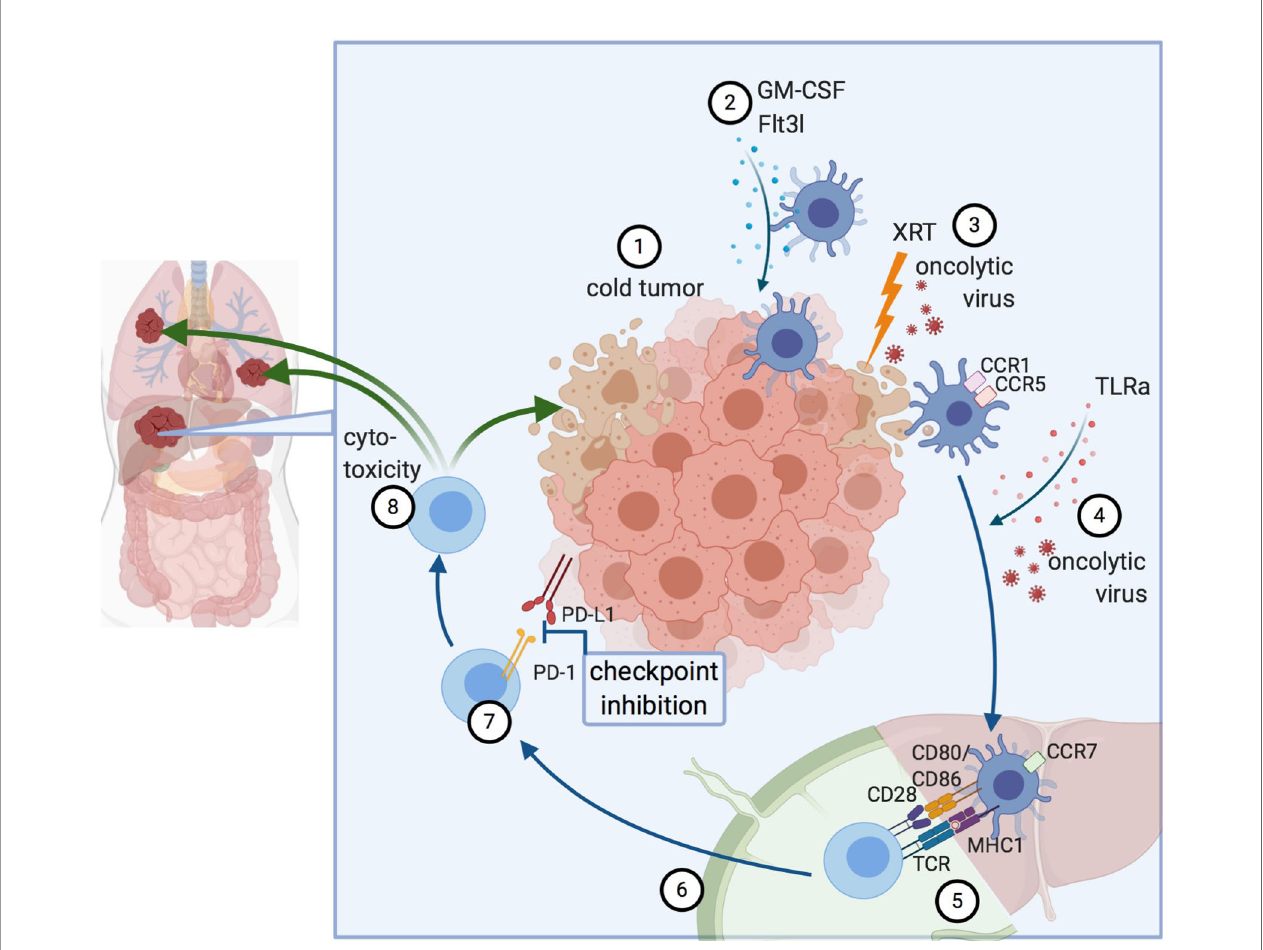
FIGURE 1 | Principles of in situ vaccines. 1) Cold tumor devoid of DCs and T cells. 2) DC recruitment to the tumor. 3) Induction of immunogenic cell death, for example by radiation or oncolytic viruses. 4) Maturation signals for DCs lead to 5) Antigen presentation and cross-priming of CD8+ T cells. This can occur either in the liver itself (in tertiary lymphoid organs forming near liver tumors) or the draining lymph node. 6) Activated T cells migrate to the tumor. 7) Abrogation of inhibitory signaling e.g. via checkpoint inhibition. 8) Cytotoxicity against the treated tumor and by abscopal effects against other lesions, as well. Created with